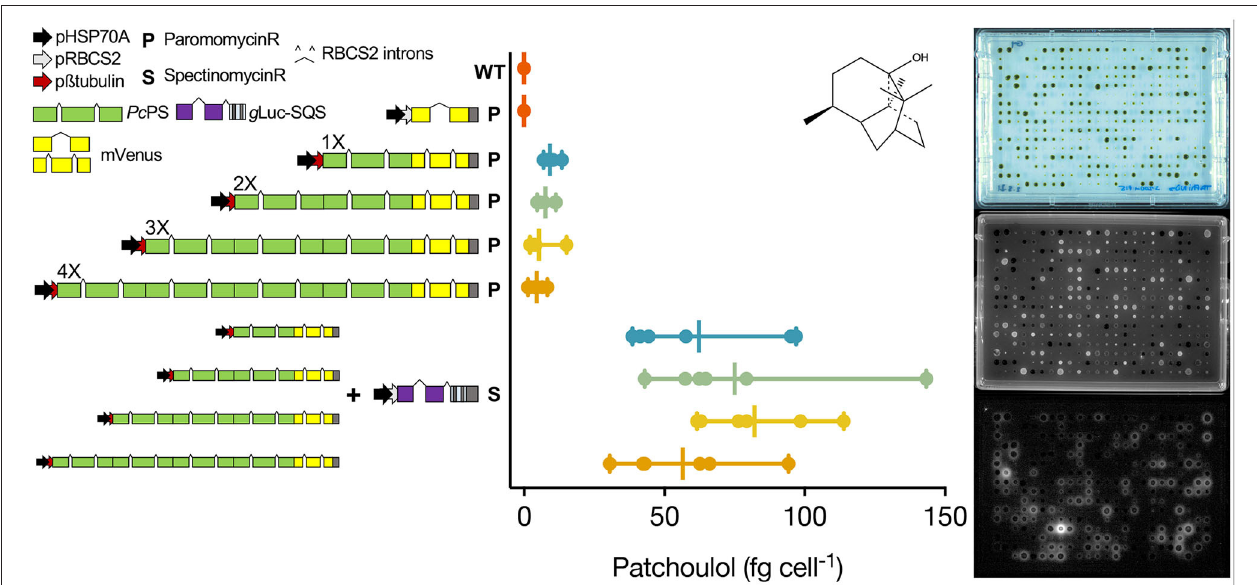
FIGURE 3 | Genetic constructs used to generate heterologous patchoulol production from a UPN strain. Single, double, triple, and quadruple copies of the C. reinhardtii codon optimized, intron containing P. cabiln patchoulol synthase were fused to generate different expression plasmids with C-terminal mVenus (YFP) reporter fusions as previously described (Lauersen et al., 2016). Each plasmid was transformed into UPN, and mVenus (YFP)-expressing colonies were isolated for each construct and benchmarked for patchoulol production ( n = 6). Patchoulol production was determined from six biological replicates ( n = 6), each measured in technical triplicates. Vertical bars show the mean and horizontal bars indicate the range of values. The chemical structure of patchoulol is shown. The best-performing individual from each plasmid was then subsequently transformed with a plasmid expressing a luciferase-amiRNA construct, which downregulates the C. reinhardtii squalene synthase. Combined high-throughput fluorescence and luciferase screening of colonies led to isolation of strains with both constructs expressed ( n = 6), which were then subsequently benchmarked for patchoulol